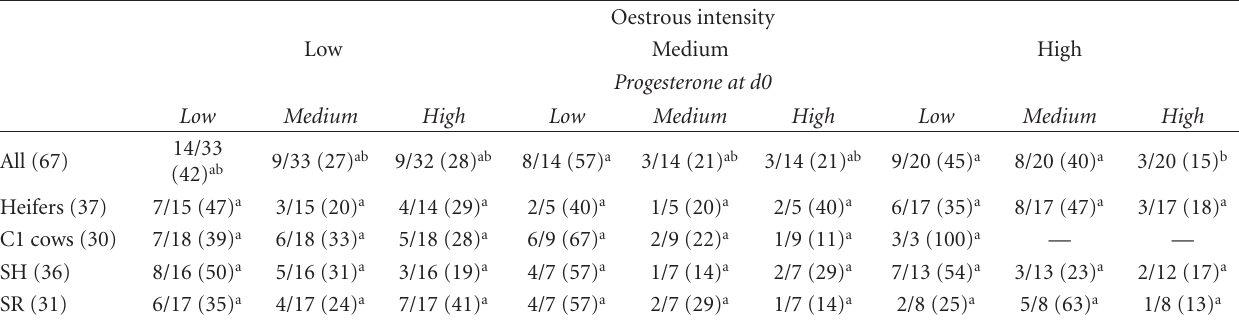
Table 2: Distribution (frequency and %) of dairy cattle according to oestrous intensity and relative progesterone (P 4 ) levels in blood serum on day 0 for all animals, as well as disclosed by category (dairy heifers (H) or first-parity cows (C1 cows)) or breed (Swedish Holstein SH or Swedish Red SR including both H and C1 cows).